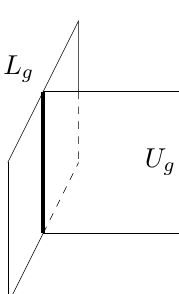
Figure 15 . Lines L g living at the intersection of a 0-form symmetry generator U g and the boundary form the sub-category C g